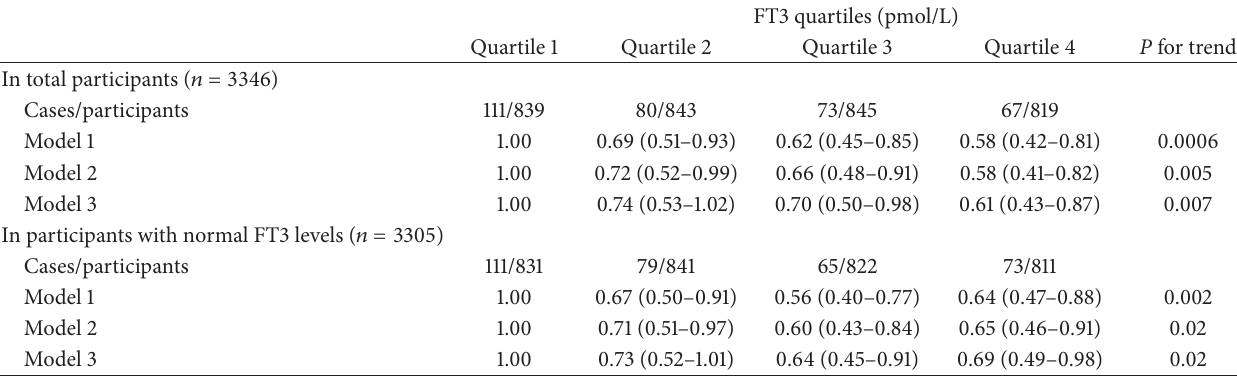
Table 2: The risk of microalbuminuria according to quartiles of